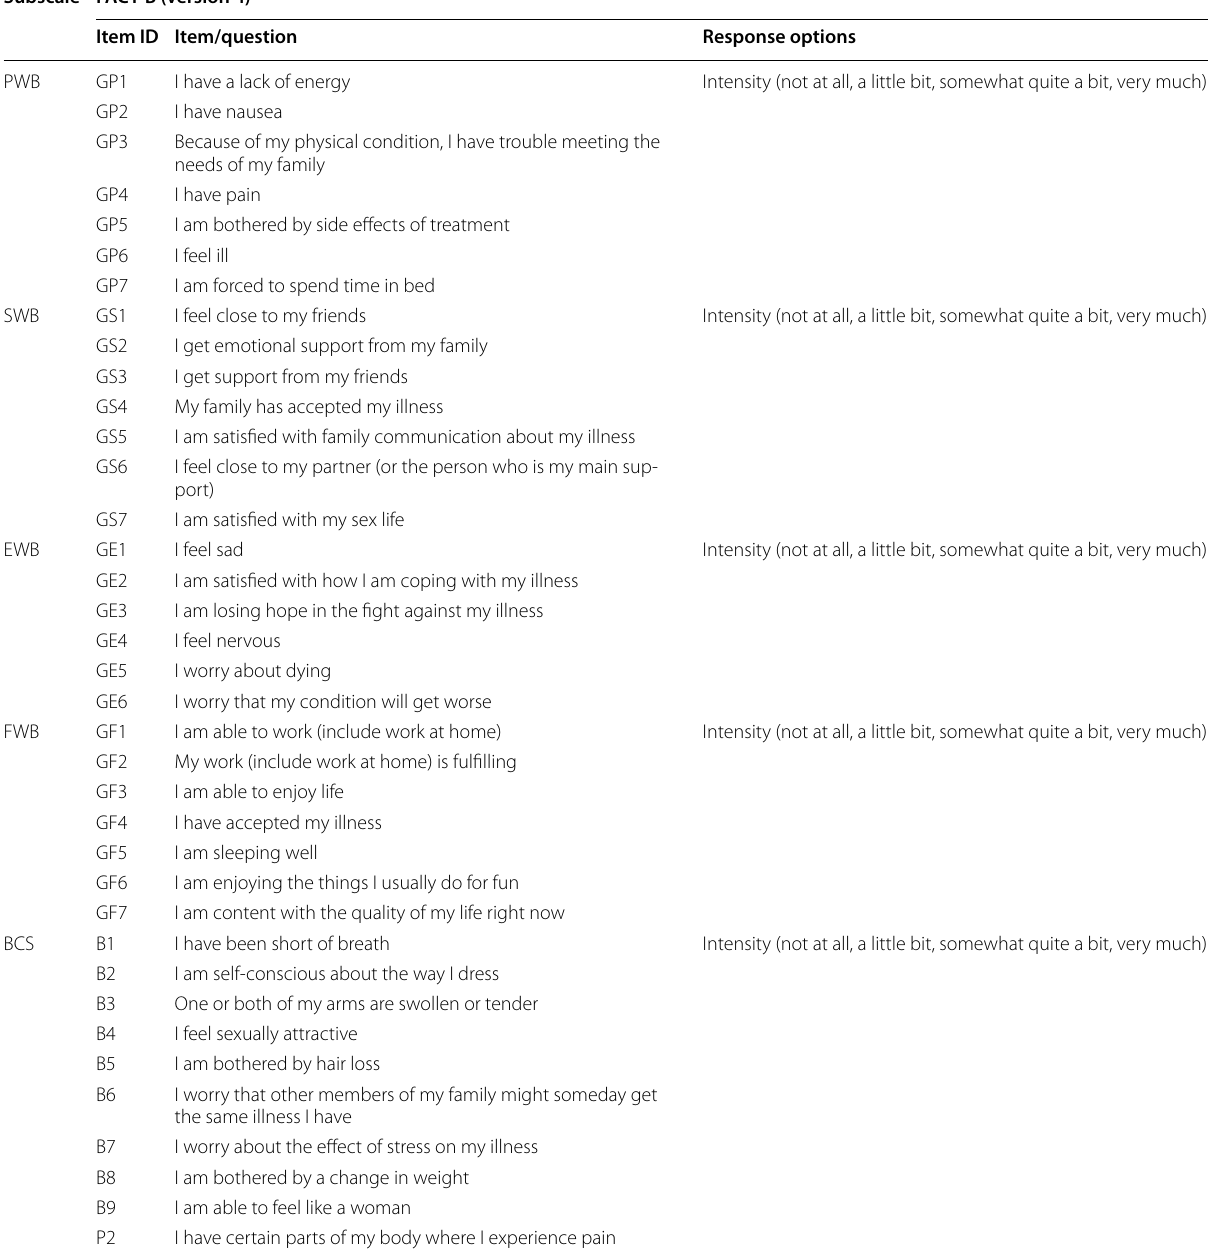
Table 1 Functional Assessment of Cancer Therapy‑Breast (FACT‑B, version 4) Subscale FACT-B (version 4) Item ID